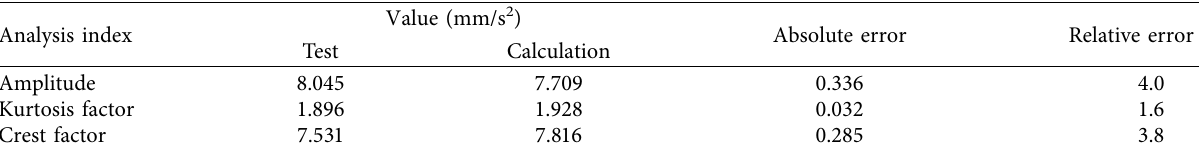
Figure 13: Comparison of impact signal: (a) time domain and (b) frequency domain. Table 5: Comparison of shock